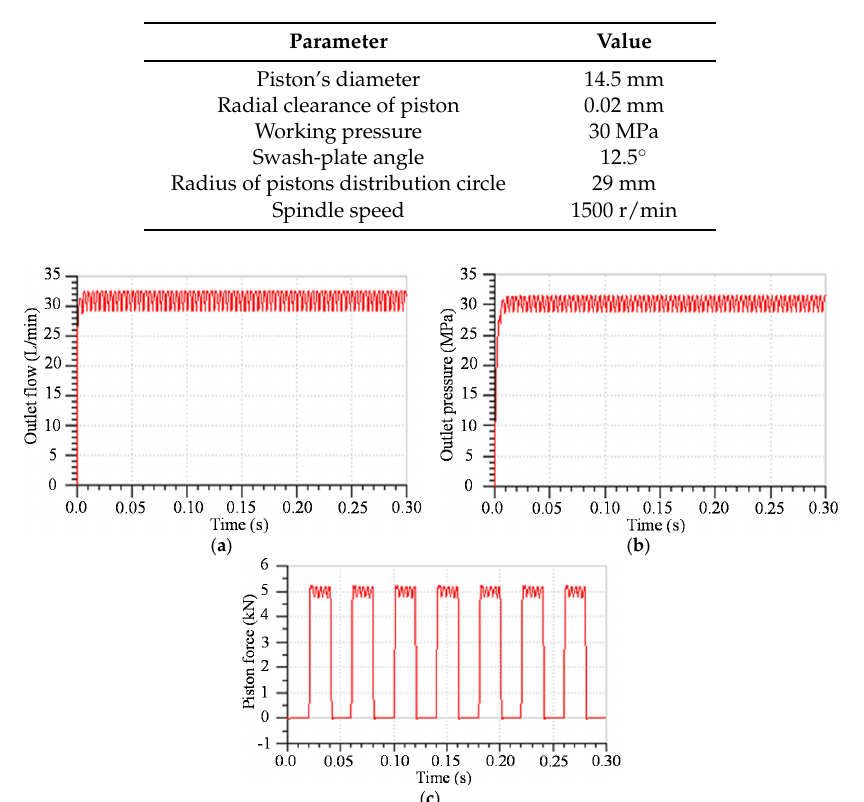
Table 1. Simulation parameters.